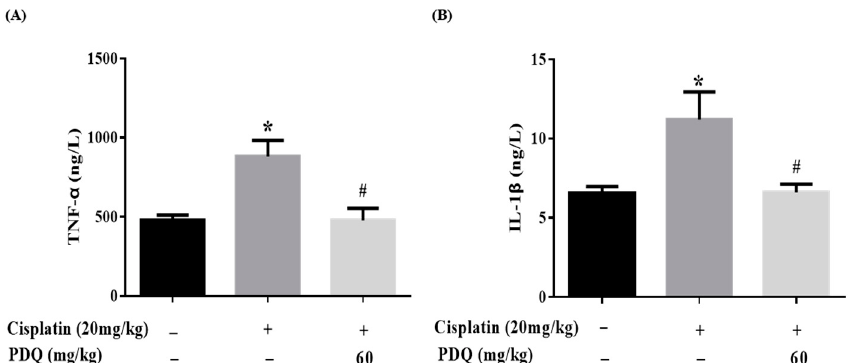
Figure 8. Effects of PDQ on the levels of inflammatory cytokines in cisplatin-induced nephrotoxicity. The levels of tumor necrosis factor- α (TNF- α ) ( A ) and interleukin-1 β (IL-1 β ) ( B ) in kidney tissues were determined by ELISA kits. All data are expressed as mean ± S.D., n = 8. * p < 0.05 vs. control group; # p < 0.05 vs. cisplatin group.